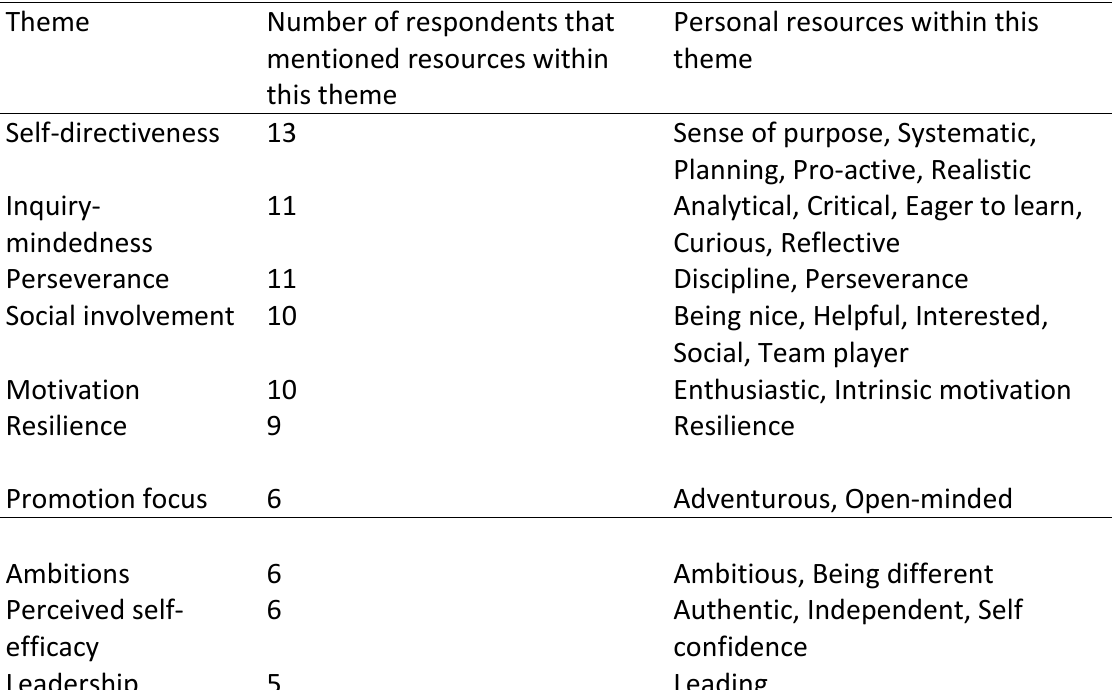
Table 1. Most frequently occurring themes and personal